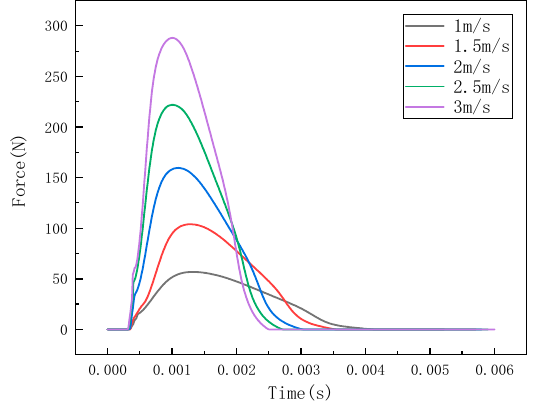
Figure 10. Impact force curve at position 2.